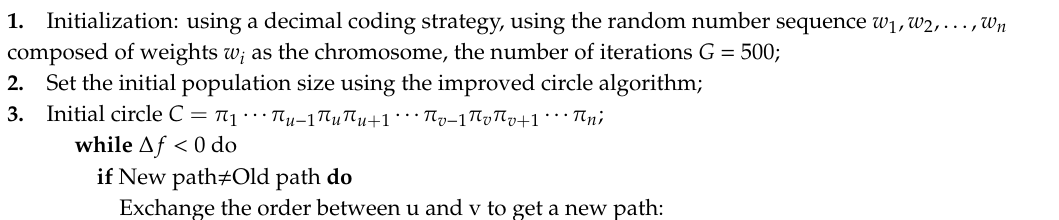
Algorithm 1 Improved genetic